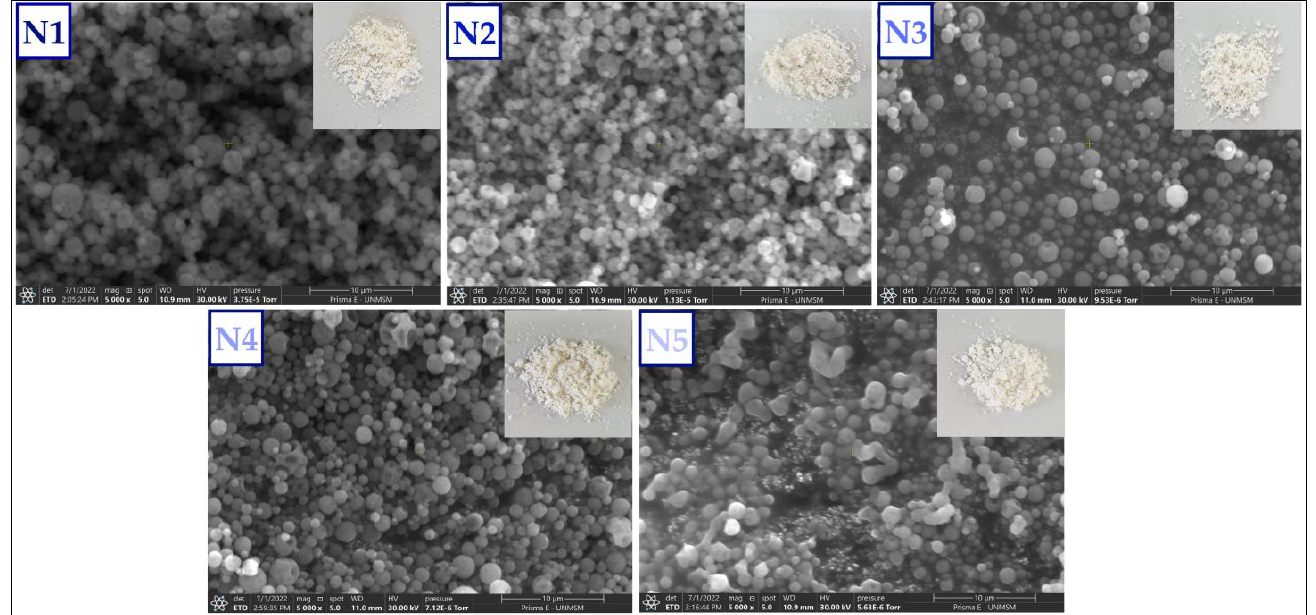
Figure 5. SEM images of propolis nanoencapsulates N1, N2, N3, N4, and N5 at 5000× magnification.